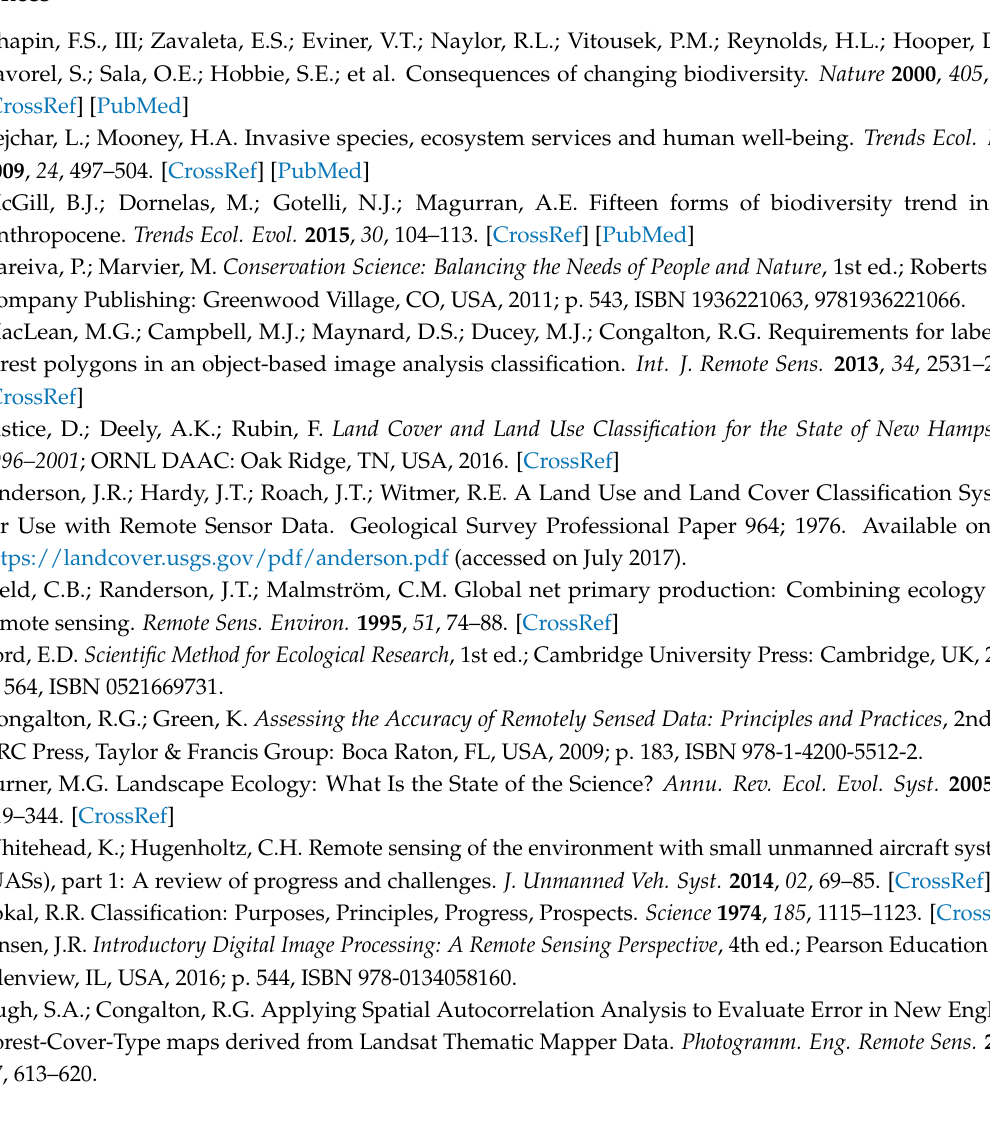
Figure S1: Pixel-based classification, Stratified Random Distribution sampling design diagram; Figure S2: Pixel-based classification, CFI-plot Positionally Dependent sampling design diagram; Figure S3: Object-based Classification, Stratified Random, Individual Subsamples sampling design diagram; Figure S4: Object-based Classification, Stratified Random Image Object Majority Agreement sampling design diagram; Figure S5: Object-based Classification, CFI-plot Dependent Individual Subsamples sampling design diagram; Figure S6: Object-based Classification, CFI-plot Dependent, Image Objects Majority Agreement sampling design